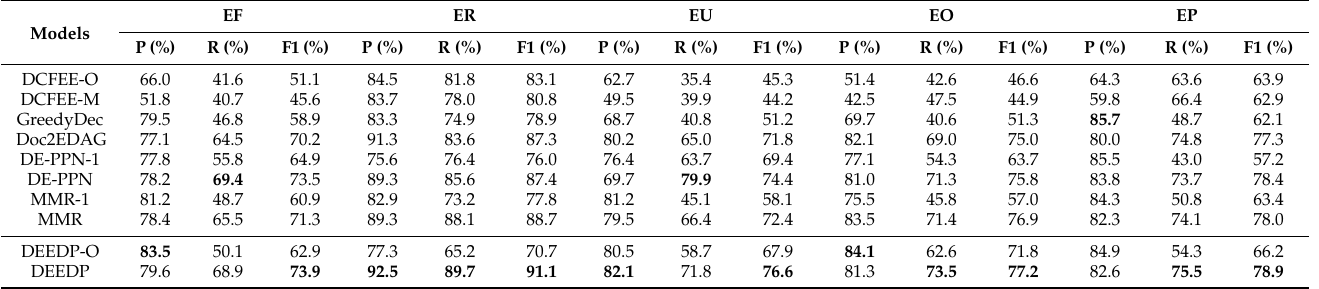
Table 3. Overall event-level precision (P), recall (R), and F1 scores evaluated on the ChFinAnn test